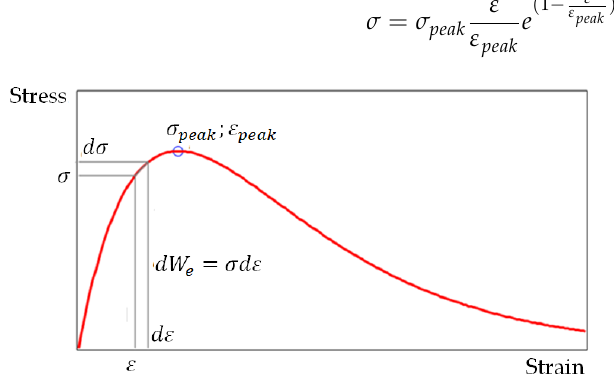
Figure 2. Stress–strain pattern.